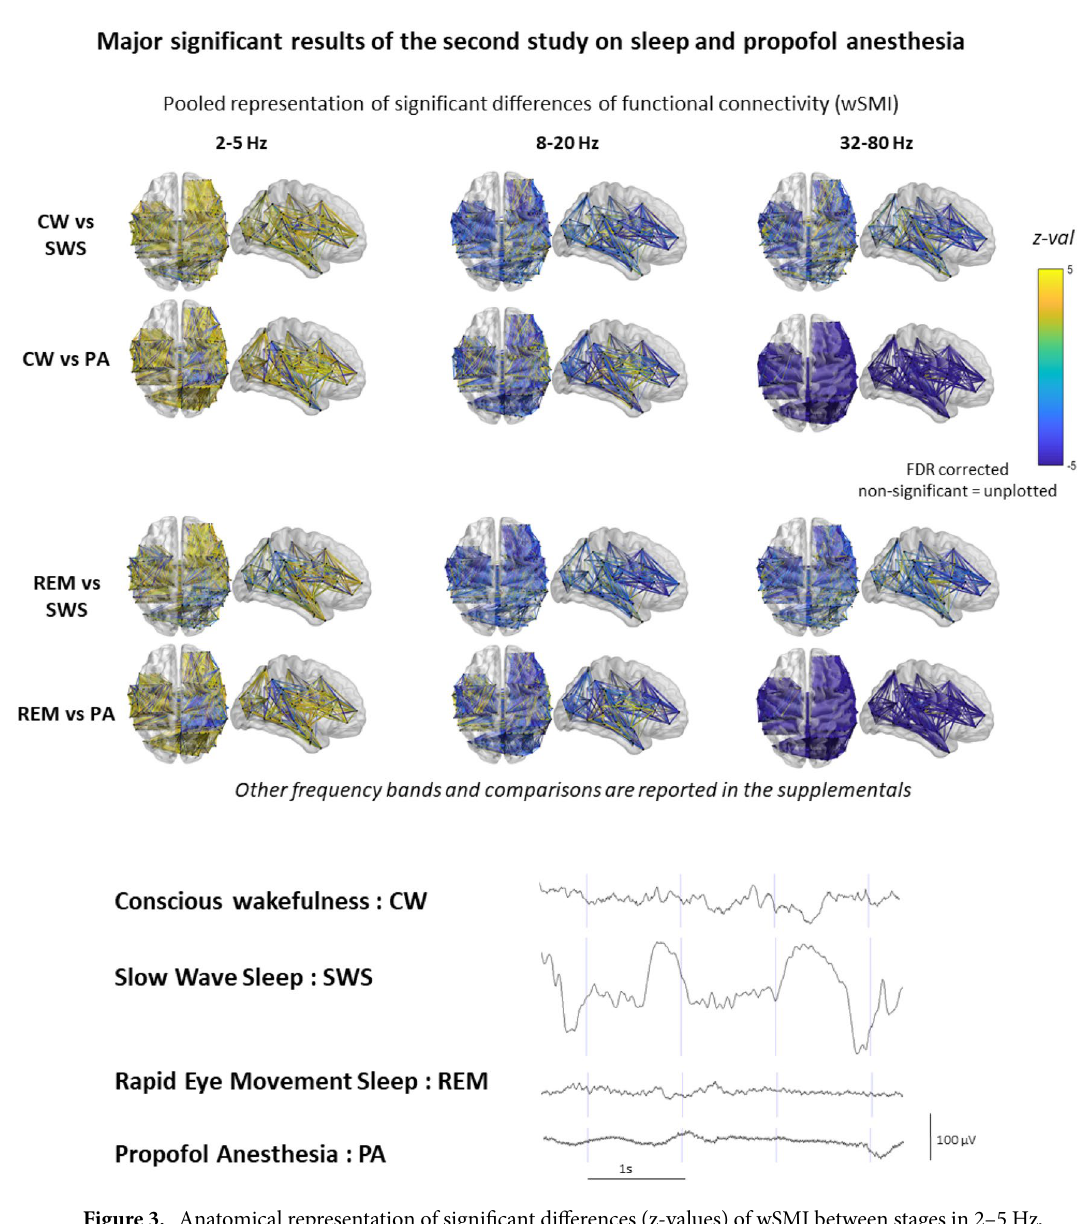
Figure 3. Anatomical representation of significant differences (z-values) of wSMI between stages in 2–5 Hz, 8–20 Hz and 32–80 Hz frequency bands. z-values of non-significant differences (after FDR correction) are not plotted. Data from the 7 patients are represented in a common MNI space. On the bottom, example of raw iEEG signal of each of the studied stages in the two first experiment. UWS unresponsive wakefulness state, VS/UWS vegetative state/unresponsive wakefulness syndrome, MCS minimally conscious state, wSMI weighted symbolic mutual